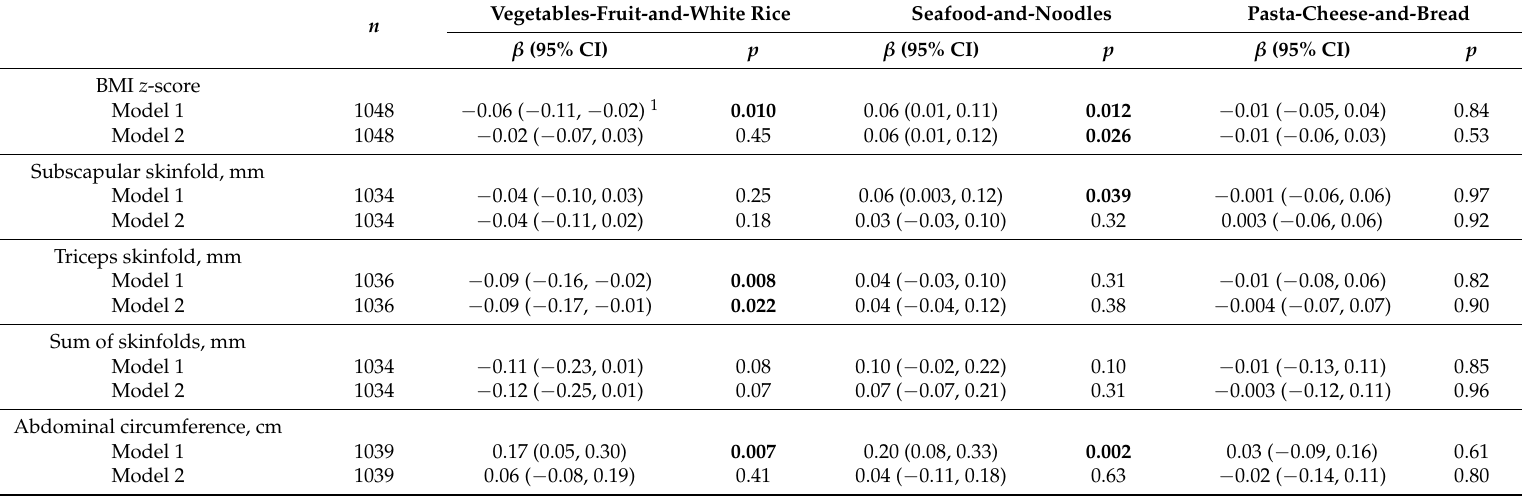
Table 3. Associations of maternal dietary pattern scores with indicators of offspring adiposity from birth through 54 months of age using linear mixed effects model.